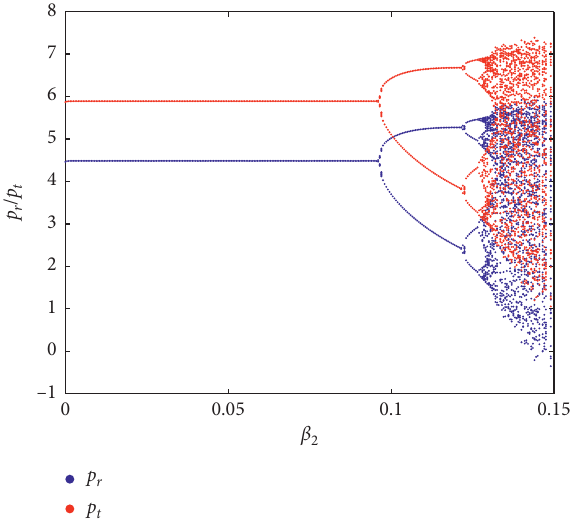
Figure 5: Bifurcation diagram of p